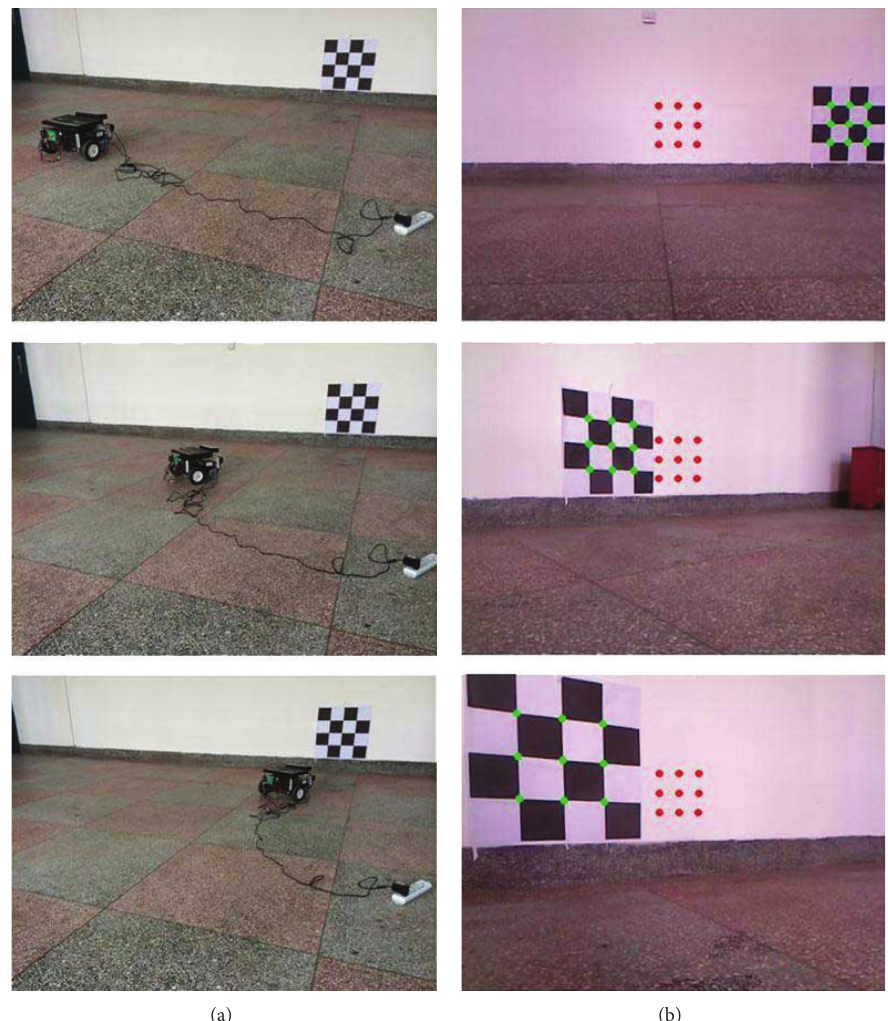
Figure 21: Experimental results. Snapshots of the robot motion (a) during the second step. Also, snapshots of the feature motion (b) superimposed on the current